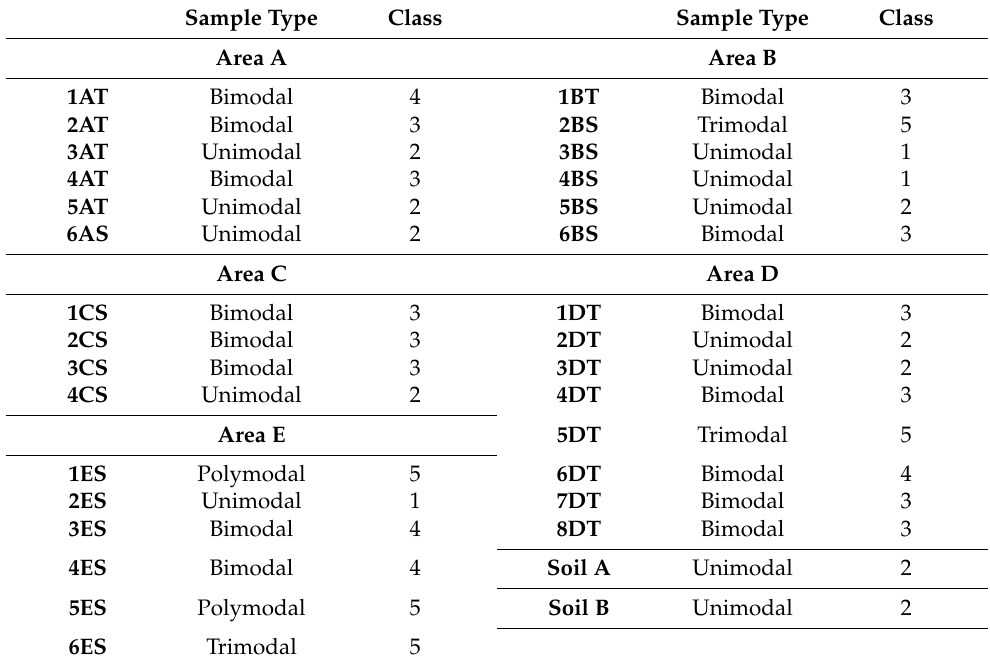
Table 3. Relationship between the samples of each area, the sample type, the grain size distribution and the sample